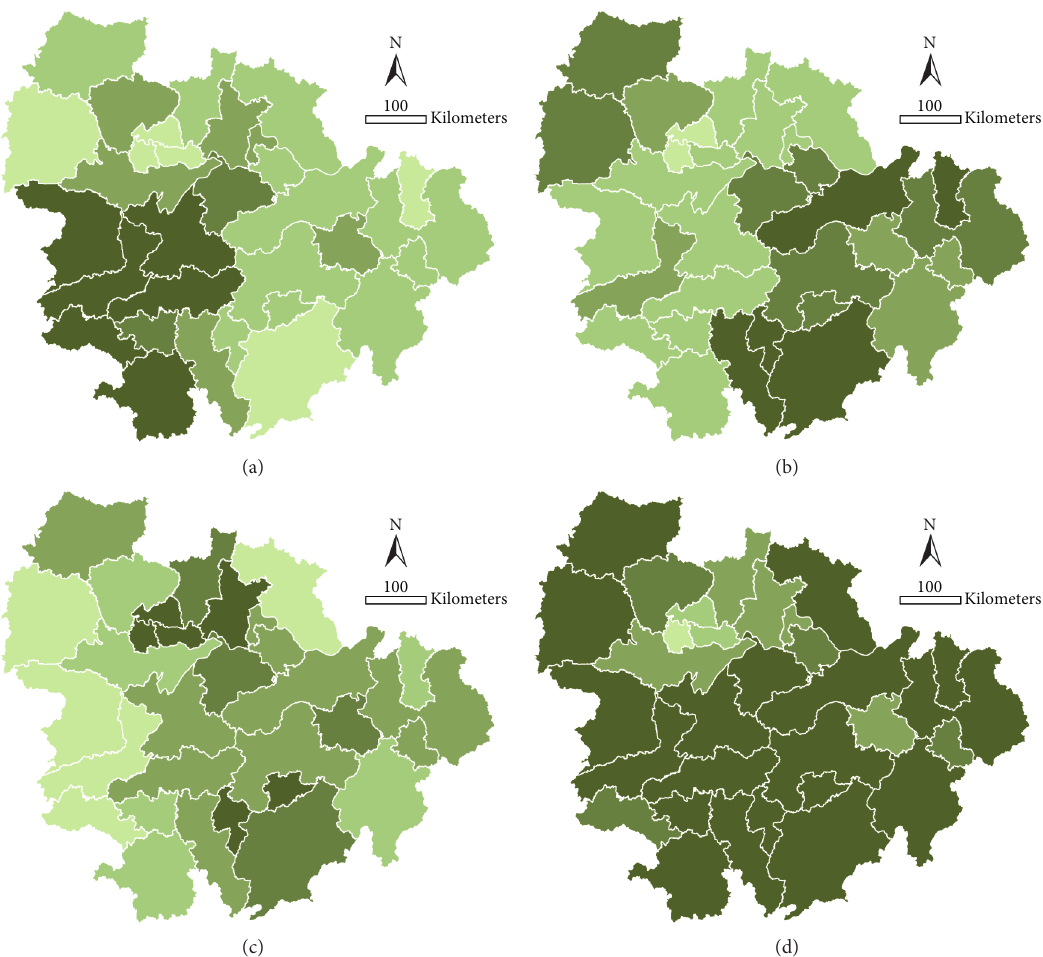
Figure 6: Landscape metrics of ecological land: (a) cls 2-PD; (b) cls 2-AL; (c) cls 2-IJI; (d) cls 2-COHESION.